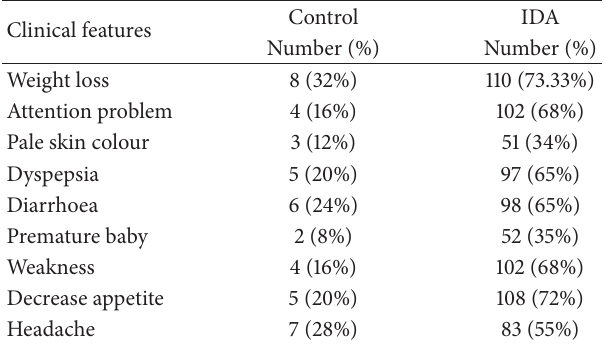
Figure 16: Showing means value of lymphocytes of control and iron deficiency anemia. Table 6: Showing the frequency of clinical features of IDA and control